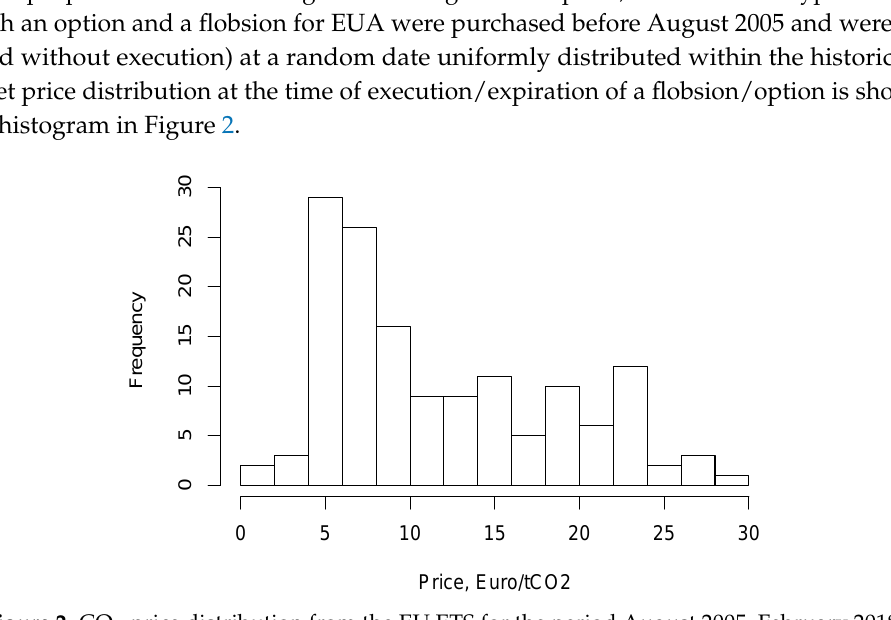
Figure 2. CO 2 -price distribution from the EU ETS for the period August 2005–February